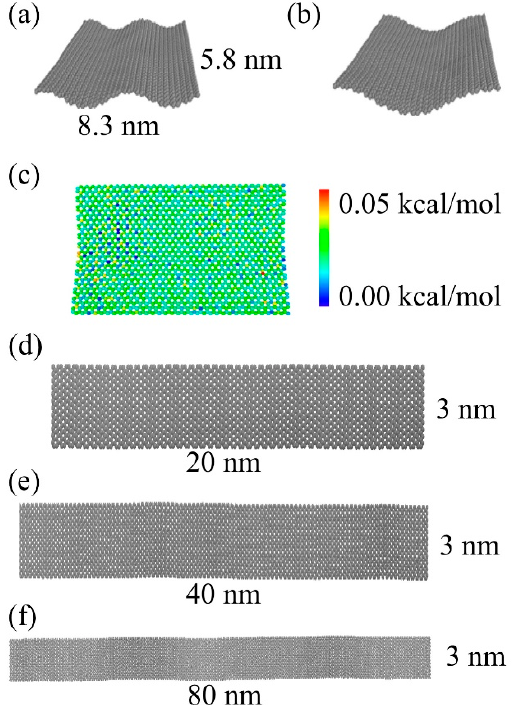
Figure 1. The free-standing graphene sheets. ( a ) Rippling of a free-standing graphene sheet obtained from the NPT simulations at 5 K with use of the periodic boundary conditions. ( b ) Final geometry of the graphene sheet after heating up to 1500 K, cooling to 77 K (with a rate 1.2 K/ps), and then annealing at 77 K for 100 ps. ( c ) Top view of the graphene sheet, color-coded based on average strain energy difference calculated for the last 100 configurations of its annealing at 77 K. ( d – f ) Initial geometries for the graphene ribbons with 3 different lengths: 20, 40, and 80